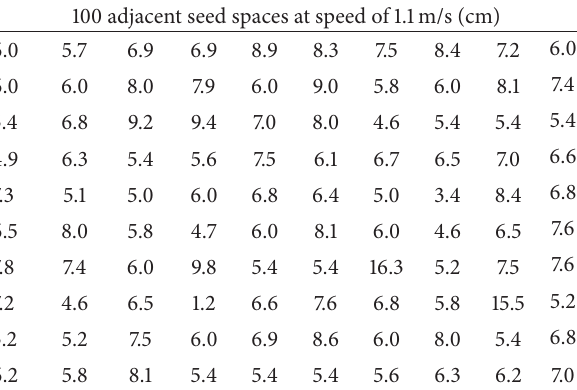
Table 7: Measured data at speed of 1.1m/s.